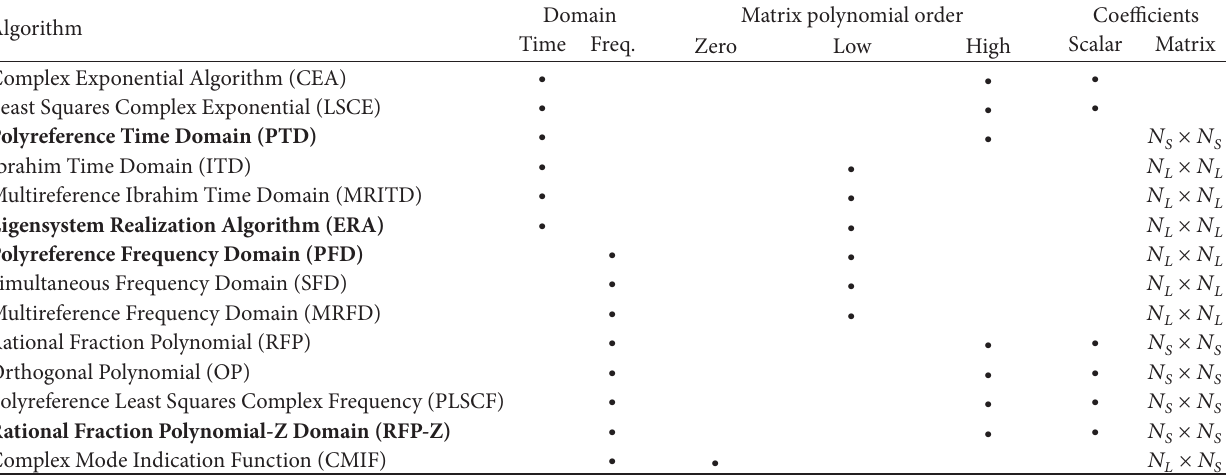
Table 1: Summary of modal parameter estimation algorithms.